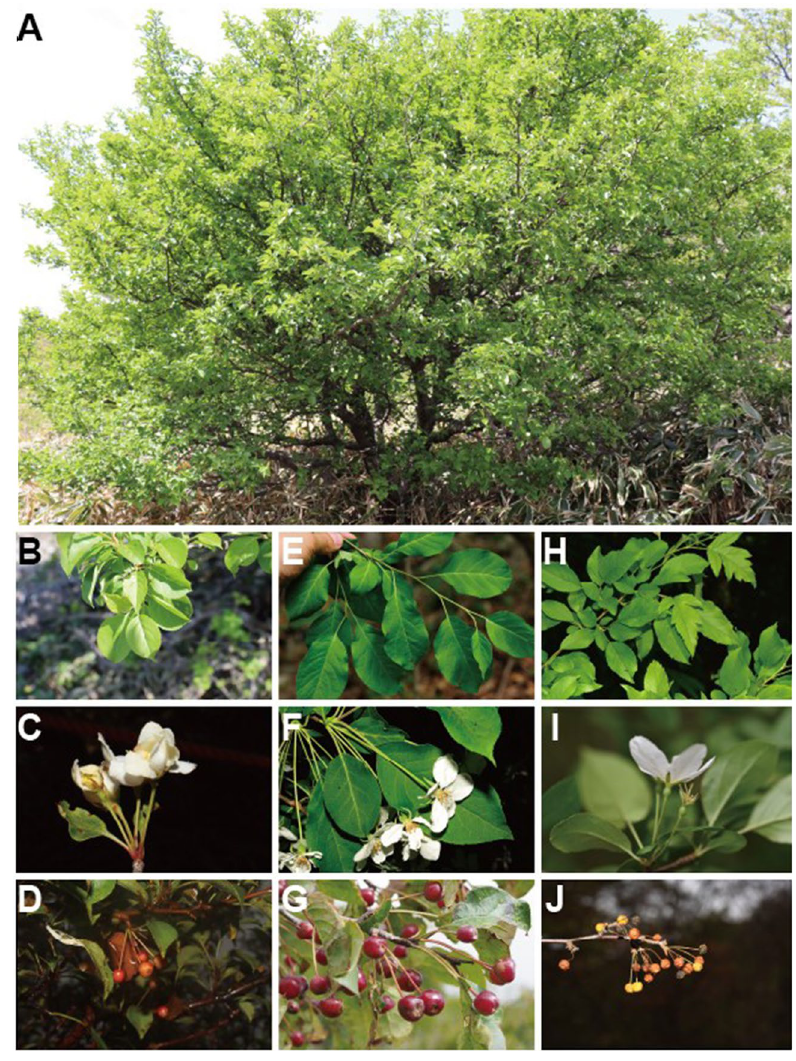
Figure 7. Photos of habitat, leaf, inflorescence, and fruits of Malus in the Korea Peninsula: A–D: M. micromalus (in Jeju Island). E–G: M. Baccata (in GW). H–J: M. Toringo (in JB). All photograph was taken by